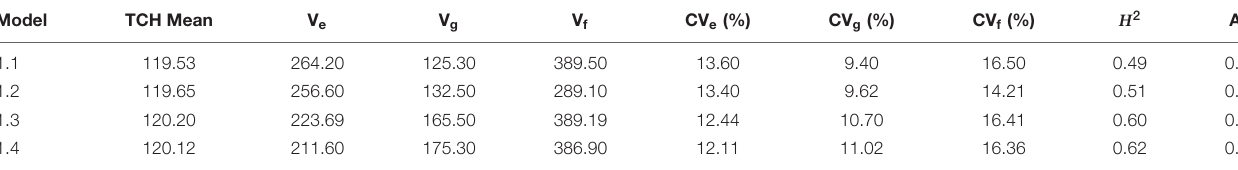
FIGURE 3 | (A) Values of the raw data of tons of cane per hectare (TCH, tons/ha) for each experimental plot (family). (B) Visualization of the spatial pattern of the TCH values, Experimental Area 1. TABLE 2 | Estimates of the variance components (REML) considering the different statistical models, Experimental Area